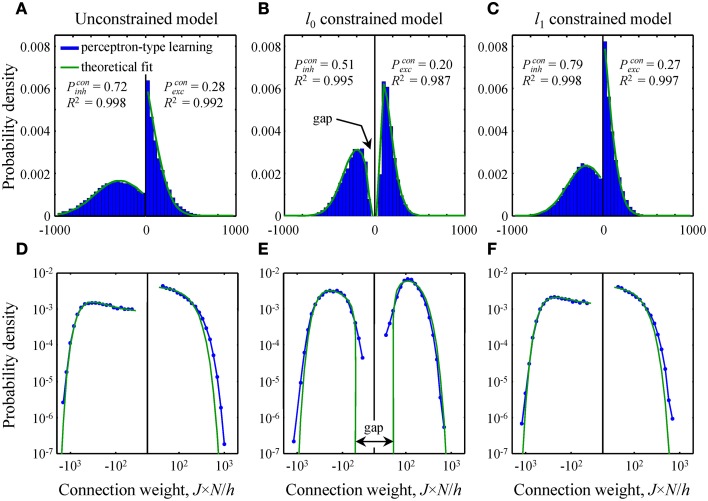
Comparison of theoretical distributions of connection weights to numerical simulations. (A–C) Probability density functions obtained with perceptron-type learning rules for N = 500, Ninh/N = 0.15, Nκ/h = 3, and finh, exc = 0.15 are shown with blue bars. Values of the constraints are w0 = 0.25 in B and Nw1/h = 70 in C. Green lines show theoretical fits of these probability density functions with Equation (10). Goodness of the fits is captured by the high adjusted R2 coefficients. The theoretical distributions of excitatory and inhibitory connection weights in the unconstrained (A) and l1 constrained (C) models consist of Gaussians truncated at J = 0 and finite fractions of zero-weight connections. The distribution in the l0 constrained model (B) also contains a finite fraction of zero-weight connections, but is non-Gaussian. This distribution has gaps between zero and non-zero connection weights for excitatory and inhibitory inputs. Parameters Pconinh,exc give theoretical fractions of inhibitory and excitatory non-zero weight connections. (D–F) Same probability density functions plotted on a log-log scale show deviations between theory and numerical simulations in the head and tail regions of the distributions.